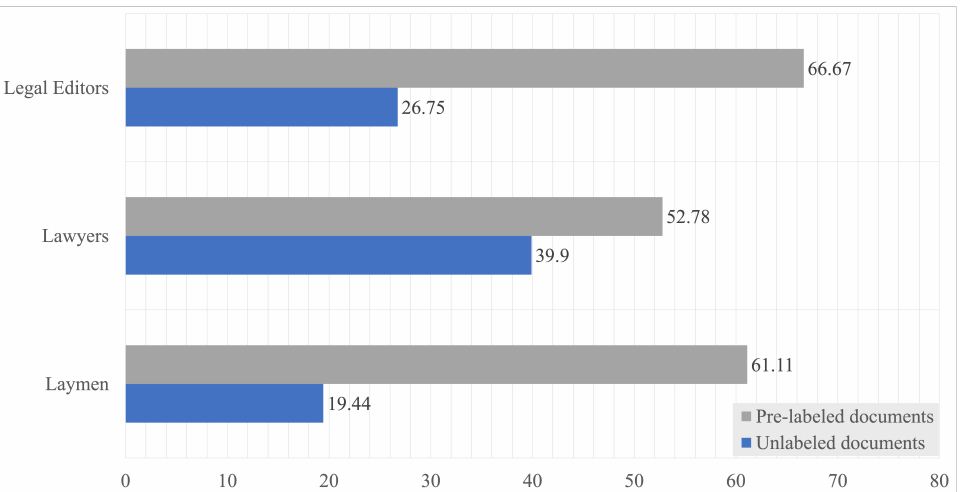
Figure 4. The proportion of the found labels on those documents, which contain at least three good labels.